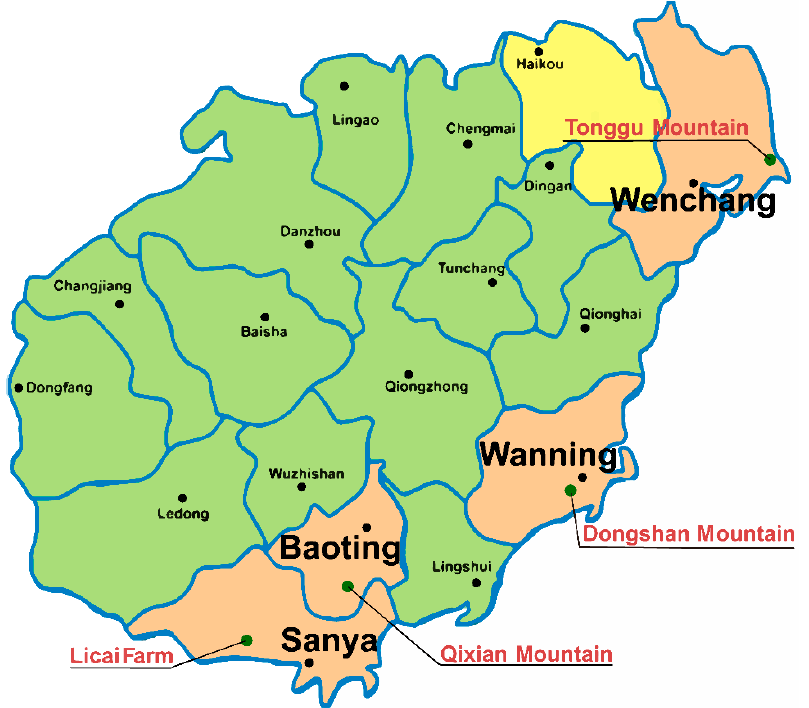
Figure 1. The specific producing areas of partridge tea samples in the southernmost province of China, Hainan, and the green dots in the figure are the sampling places.